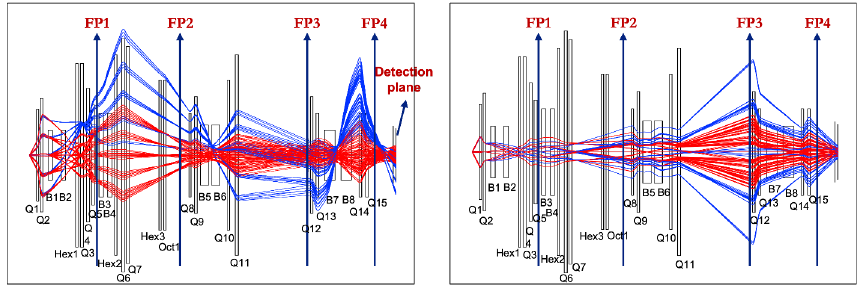
Figure 1. The ion optics of SECAR. The characteristic rays in the horizontal and vertical planes are shown in the left and right panel, respectively. The red lines represent the 58 Co 22 + recoils, while the blue ones the unreacted 58 Fe 22 + ions. The mass slits at every focal plane were used to cut down the majority of the unreacted